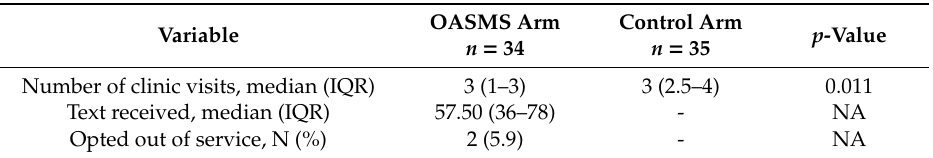
Table 2. Baseline characteristics.